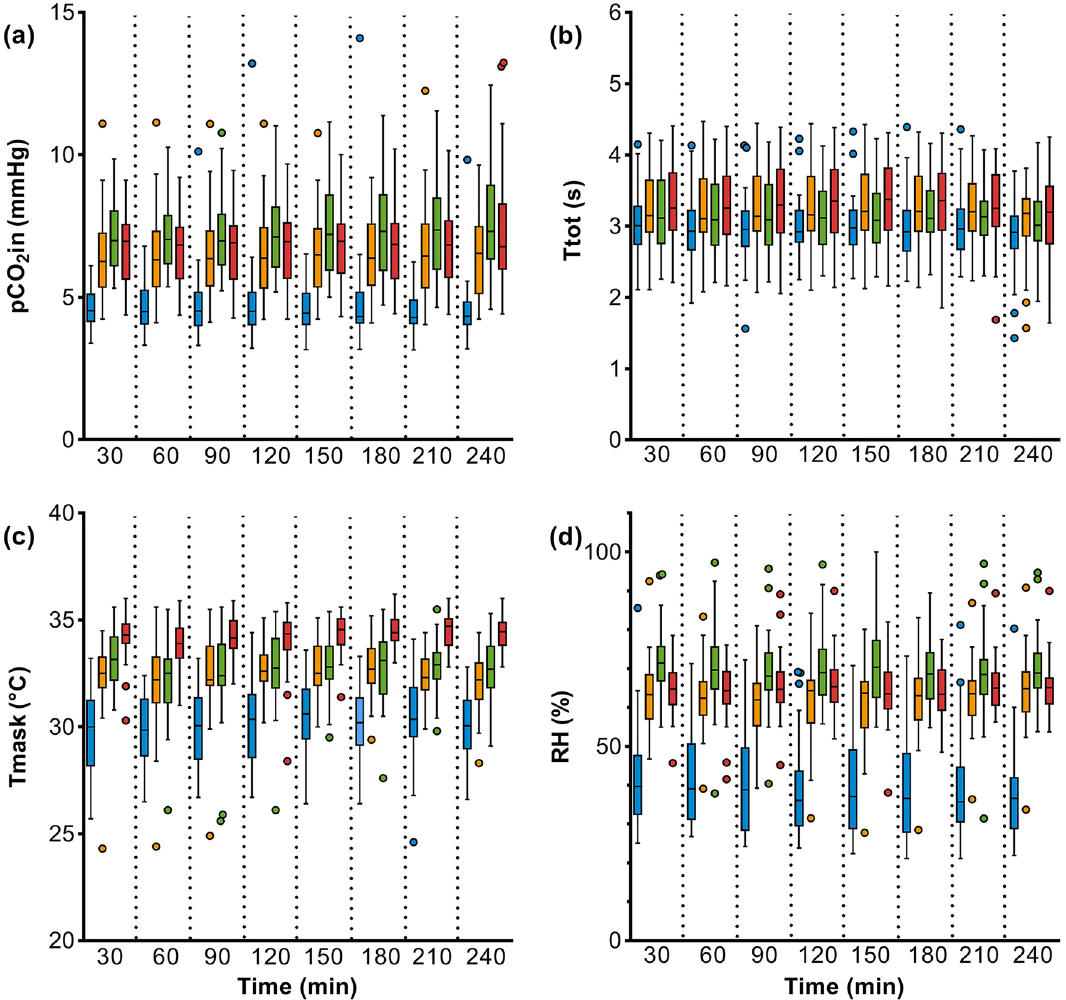
Figure 4. Workplace measurement: Results of ( a ) inspiratory CO 2 behind the mask (pCO 2 in), ( b ) inspiratory and expiratory time (Ttot), ( c ) temperature behind the mask (Tmask), and ( d ) relative humidity behind the mask (RH) in 40 subjects wearing no mask (blue), surgical mask (yellow), community mask (green), and FFP2